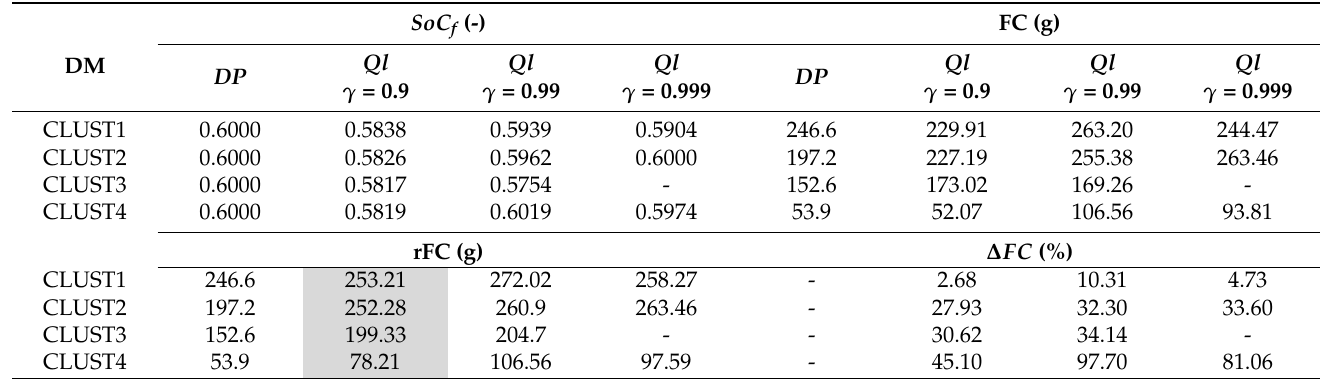
Table 2. Effect of the discount factor on a Q-learning based energy management system of a hybrid electric vehicle under real-world driving conditions.